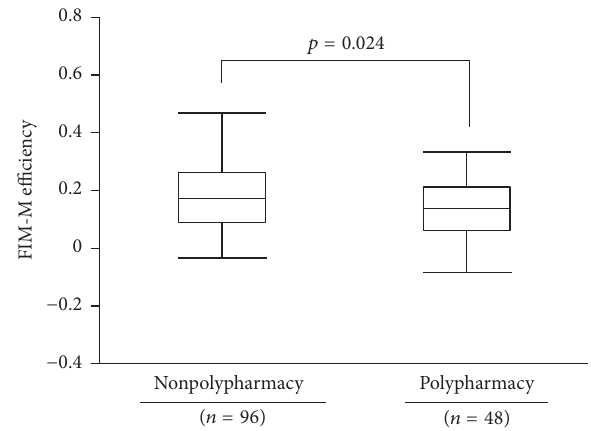
Figure 2: Effect of polypharmacy on FIM-M efficiency. We used the Mann–Whitney 𝑈 -test to compare FIM-M efficiency between polypharmacy and nonpolypharmacy. Polypharmacy: six or more drugs; nonpolypharmacy: less than six